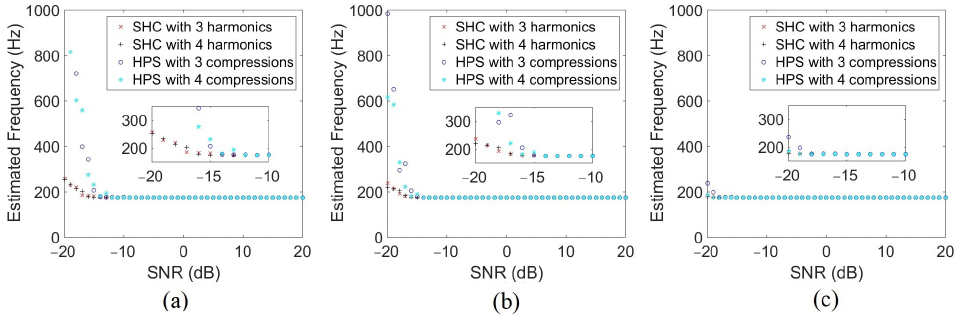
Figure 10. Evolution of the estimated blade passing frequency as a function of the SNR for a simulated source with HPS with three or four compressions and SHC with N H = 3 or N H = 4, with 2048 points ( a ), 4096 points ( b ), and 8192 points ( c ) for the